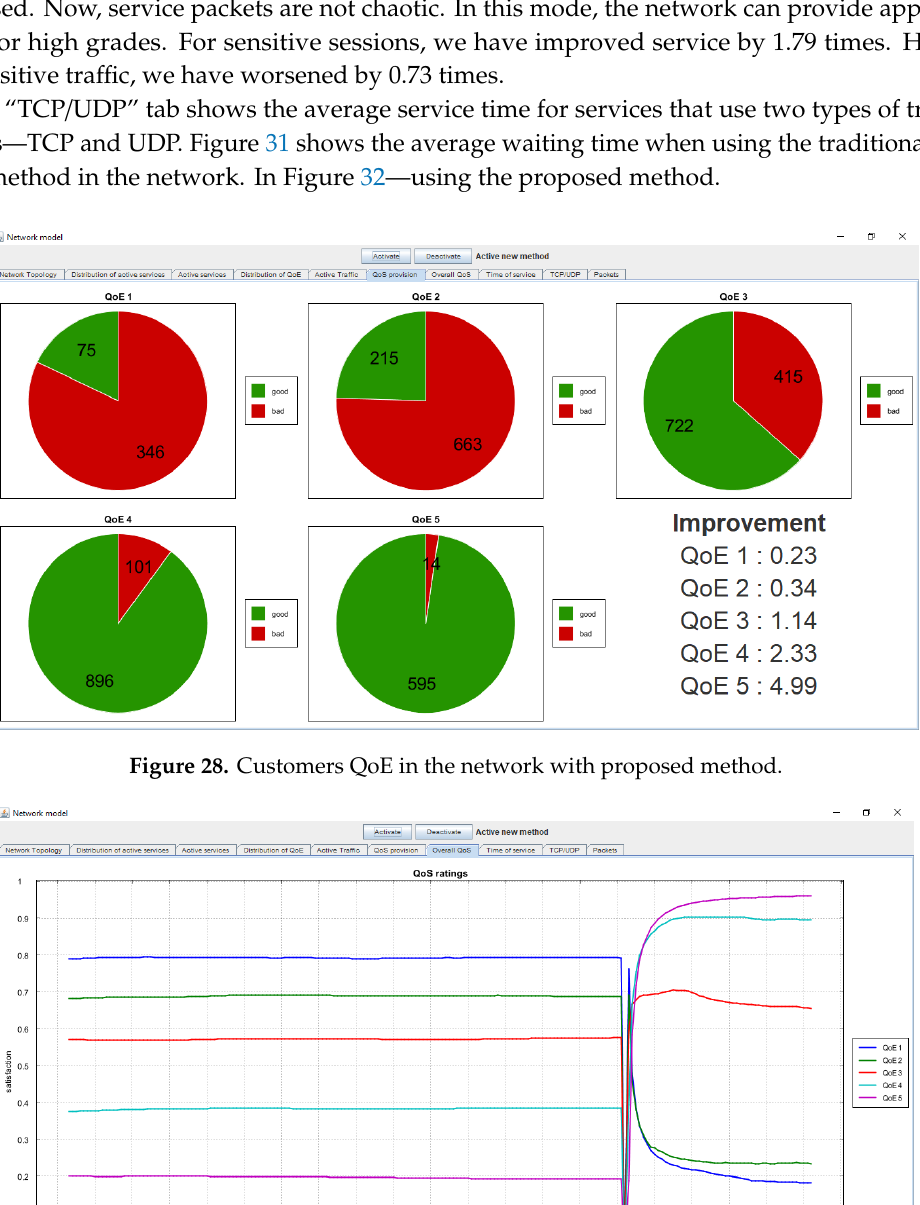
Figure 30. The average waiting time for each session with corresponding QoE score using the proposed method. Figure 31. The average waiting time for TCP/UDP (Transmission Control Protocol, User Datagram Protocol) services using the traditional method.